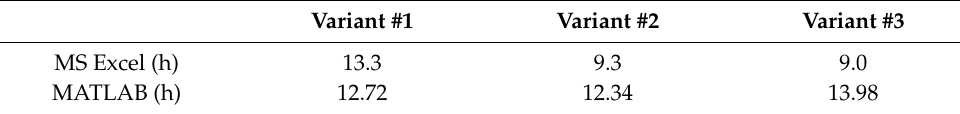
Table 9. Comparison of the results of the delivery time for the three variants.